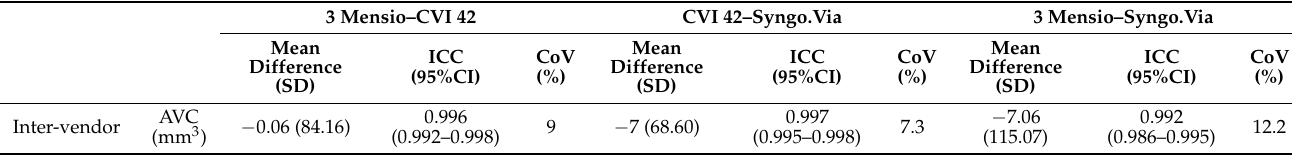
Figure 4. Bland-Altmann plots for inter-vendor agreement. The inter-vendor agreement on the degree of AVC. Bland- Altmann plots with limits of agreement (95% confidence intervals) demonstrate the inter-vendor reproducibility of MDCT-derived AVC. MDCT: multidetector computed tomography; AVC: aortic valve calcification. Table 2. Inter-vendor agreement and reproducibility.